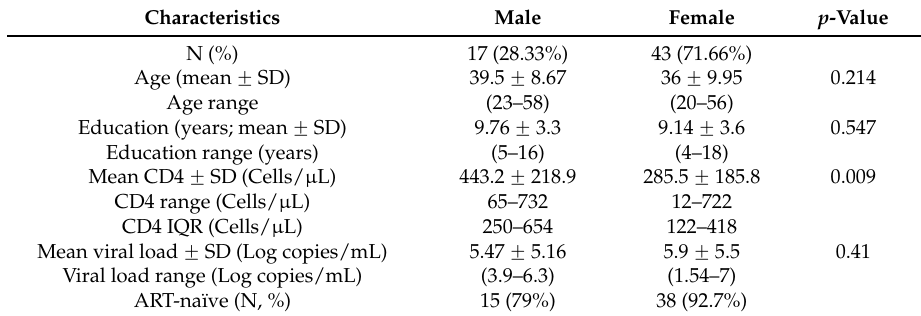
Table 1. Demographics and laboratory characteristics of patients included in the